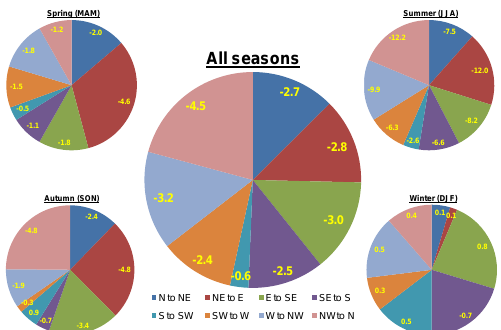
Fig. A2. Daily average fluxes of latent heat (LE) and sensible heat ( H ) over the study period. Both units are Wm − 2 . Fig. A3. Seasonal changes in average half-hourly CO